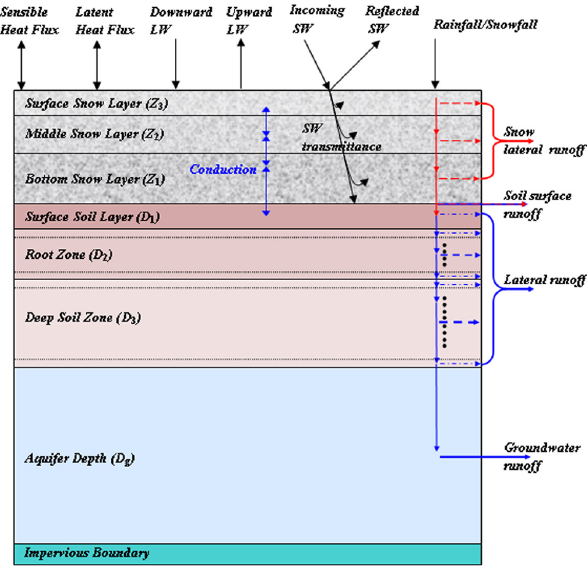
Fig. 1. The soil model coupled with a three-layer snow model as described in